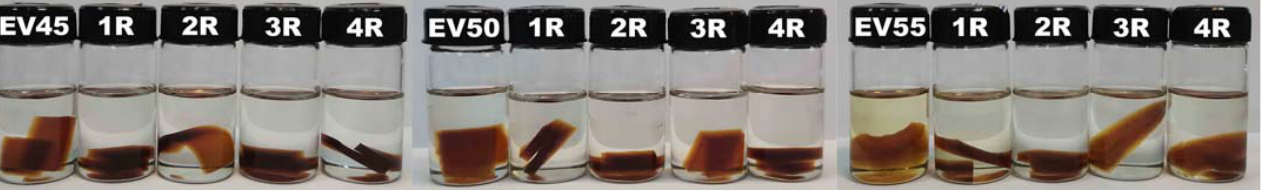
Figure 5. Solvent stability of the original and recycled epoxy vitrimers in toluene at room temperature after 48 h.